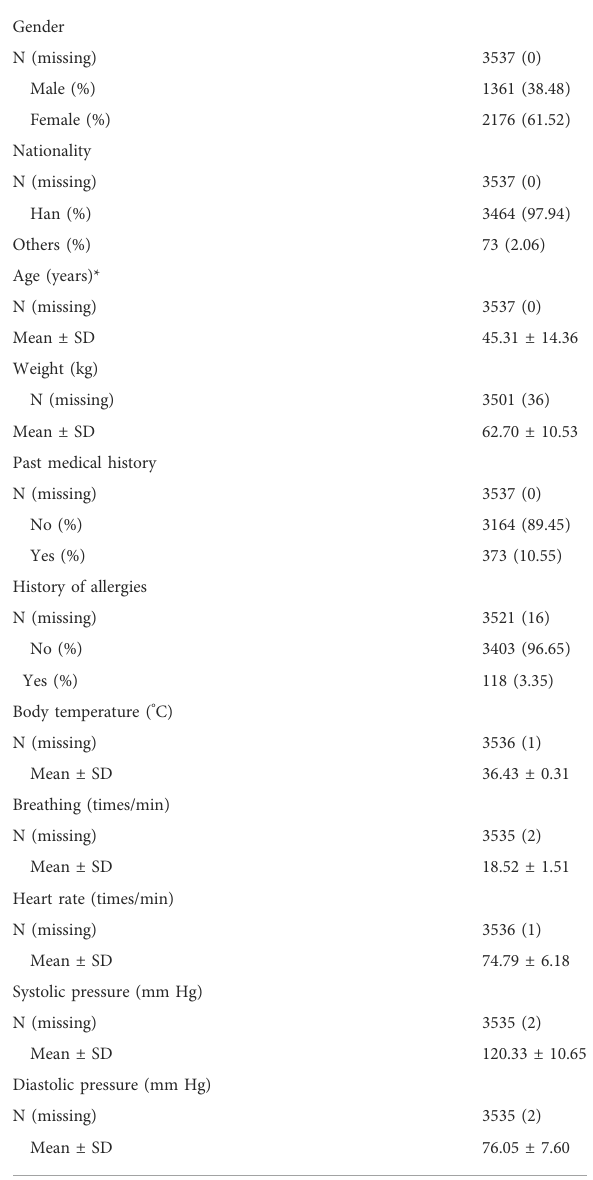
TABLE 2 Baseline demographic characteristics of the subjects in the